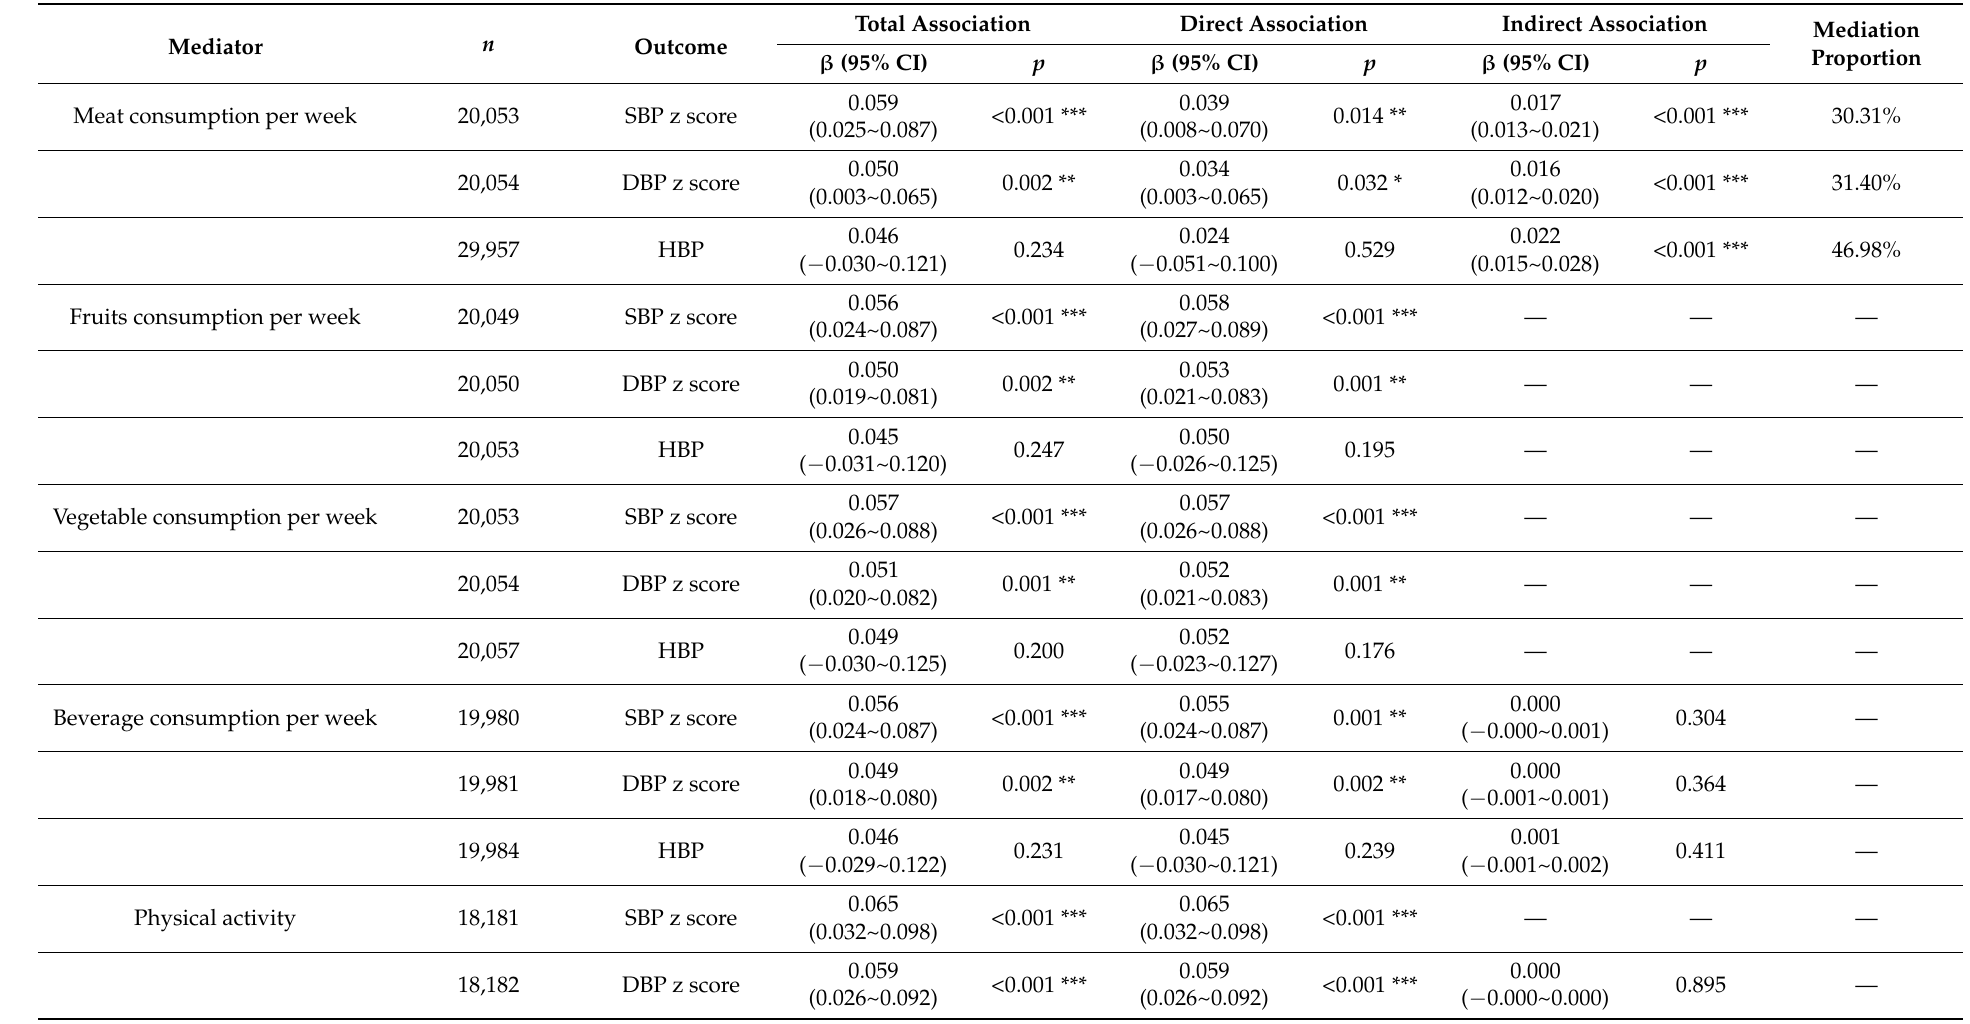
Table 3. Mediation of lifestyle behaviors on the association between single-child status and BP in girls ( n =